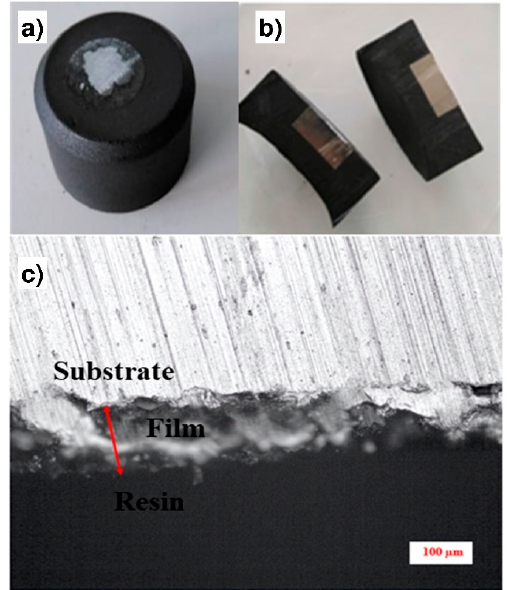
Figure 6. Methodology for the coating thicknesses measurement: ( a ) The sample is embedded into a resin block; ( b ) Cross-section of the resin block; ( c ) Optical observation of the